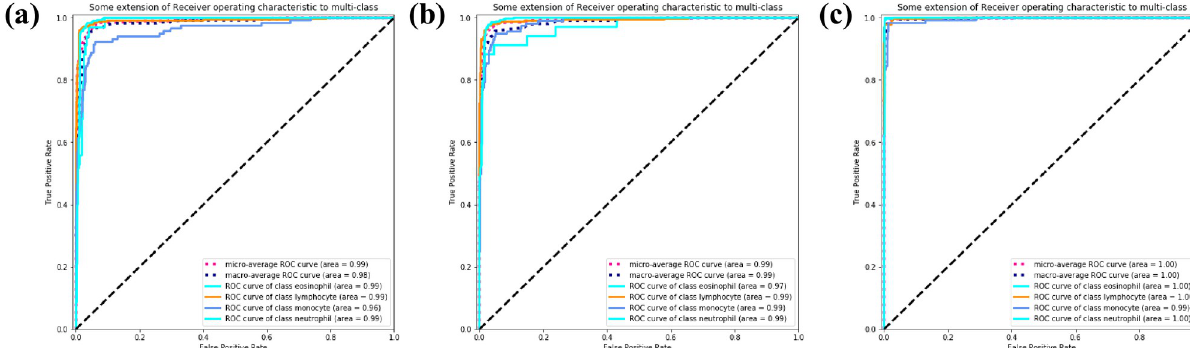
Fig 12. ROC curve. (a) MobileNetV2. (b) ResNet. (c) SE-ResNeXt.